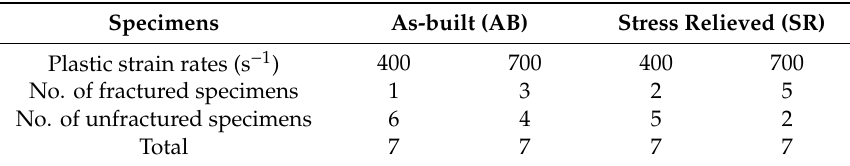
Table 3. Conditions of the specimens after dynamic compression testing.